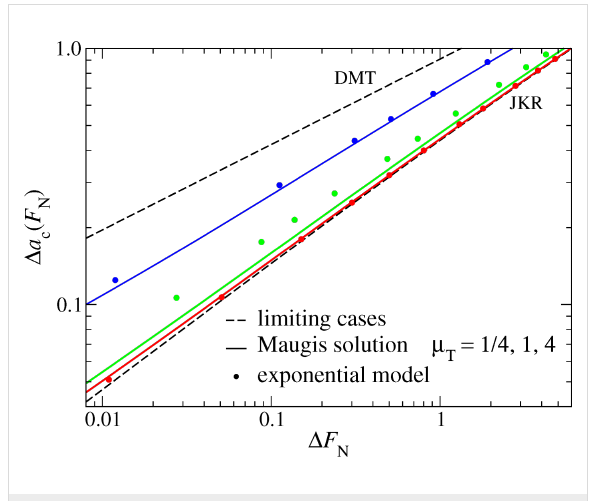
Figure 15: Excess contact radius Δ a c = a c − a p as a function of the excess load Δ F N = F N + F p for different values of the Tabor coefficient ranging from μ T = 0 (DMT, top) to μ T → ∞ (JKR, bottom). Here a c and a p denote the contact radius at an arbitrary load F N and the pull-off load F p , respectively. Deviations between the Maugis solution and the exponential model are particularly obvious for the μ T = 1 data set. Color coding: μ T = 4 (red), μ T = 1 (green), and μ T = 1/4